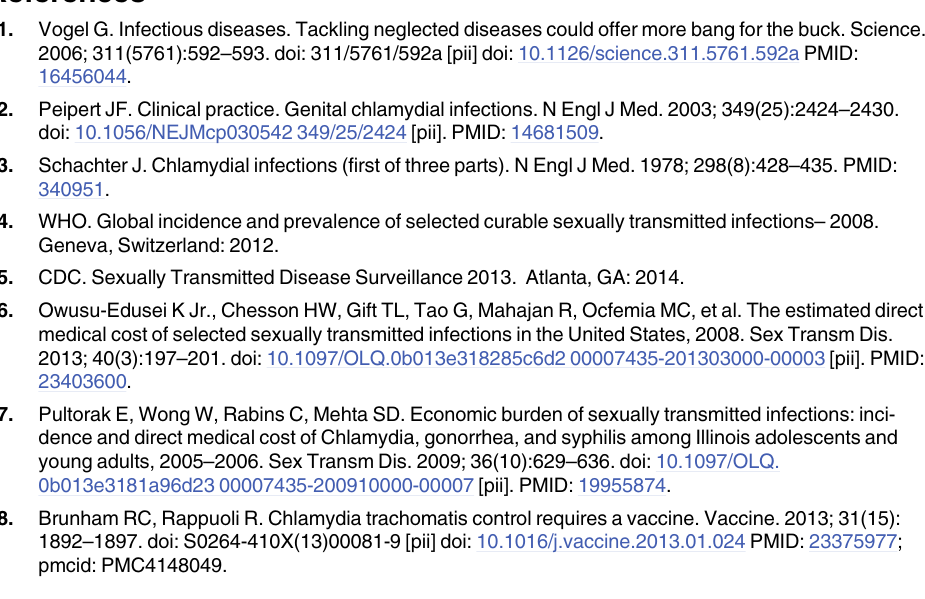
(panel B), PmpG (panel C) and PmpH (panel D) among strains representative of the main branches of each phylogentic tree. S1 Table. In silico promoter predictions for pmpFE operon regulatory region. S2 Table. In silico promoter predictions for pmpGH operon regulatory